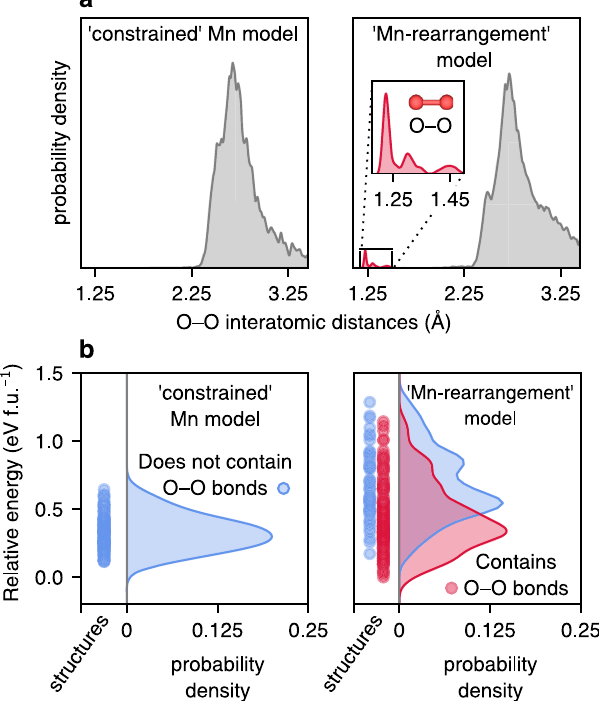
Fig. 2 | Search for O – O bonds and thermodynamics of O-dimer formation in delithiated Li 0.67 MnO 2 F. a Search for O – O dimers by an analysis of O – O intera- tomic distances in delithiated structures of thepristinematerial obtained from the cluster-expansion ( ‘ constrained ’ Mn), and in ‘ Mn rearrangement ’ models. b Energetics of the structures from a with the structures from the ‘ Mn-rearrange- ment ’ model separated into those containing O – O bonds (<1.7Å) and those not containing O – O bonds. The right section of each panel shows the kernel density estimations of the probability of energies in the left panel, where each dot is the energy of one structure.